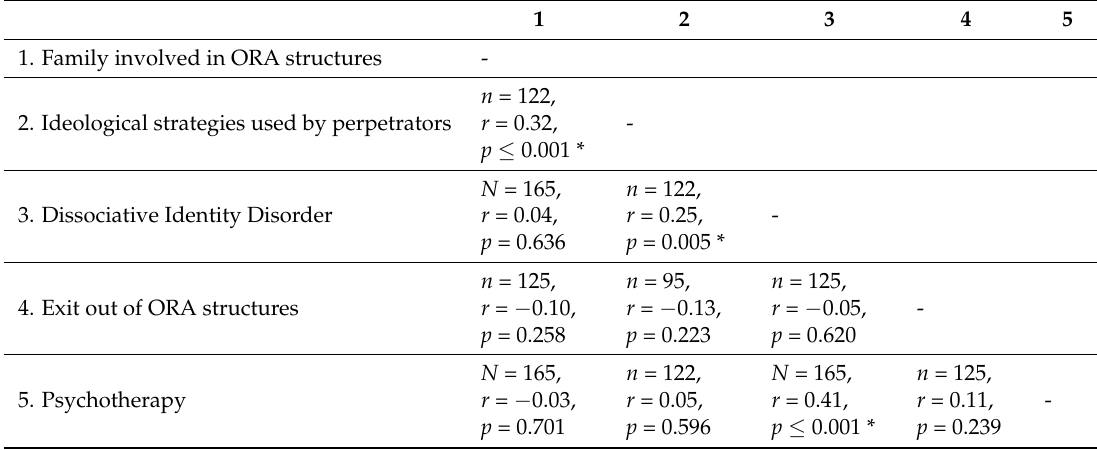
Table 5. Correlations between ORA-related and clinical variables in 165 self-identified